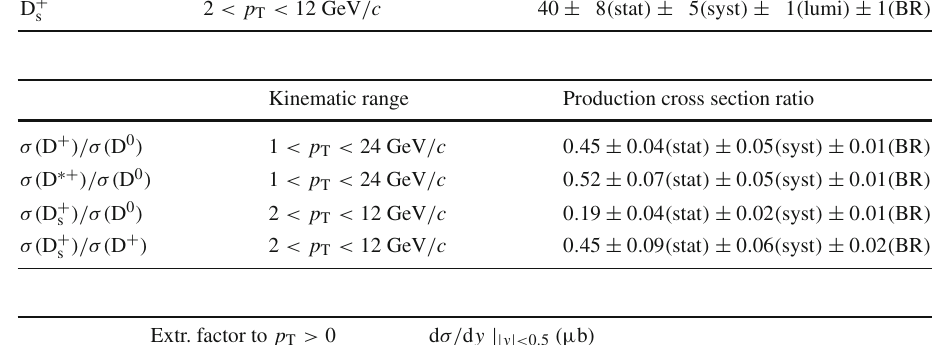
sections of prompt D mesons in | y | < 0 . 5 and full p pp collisions at